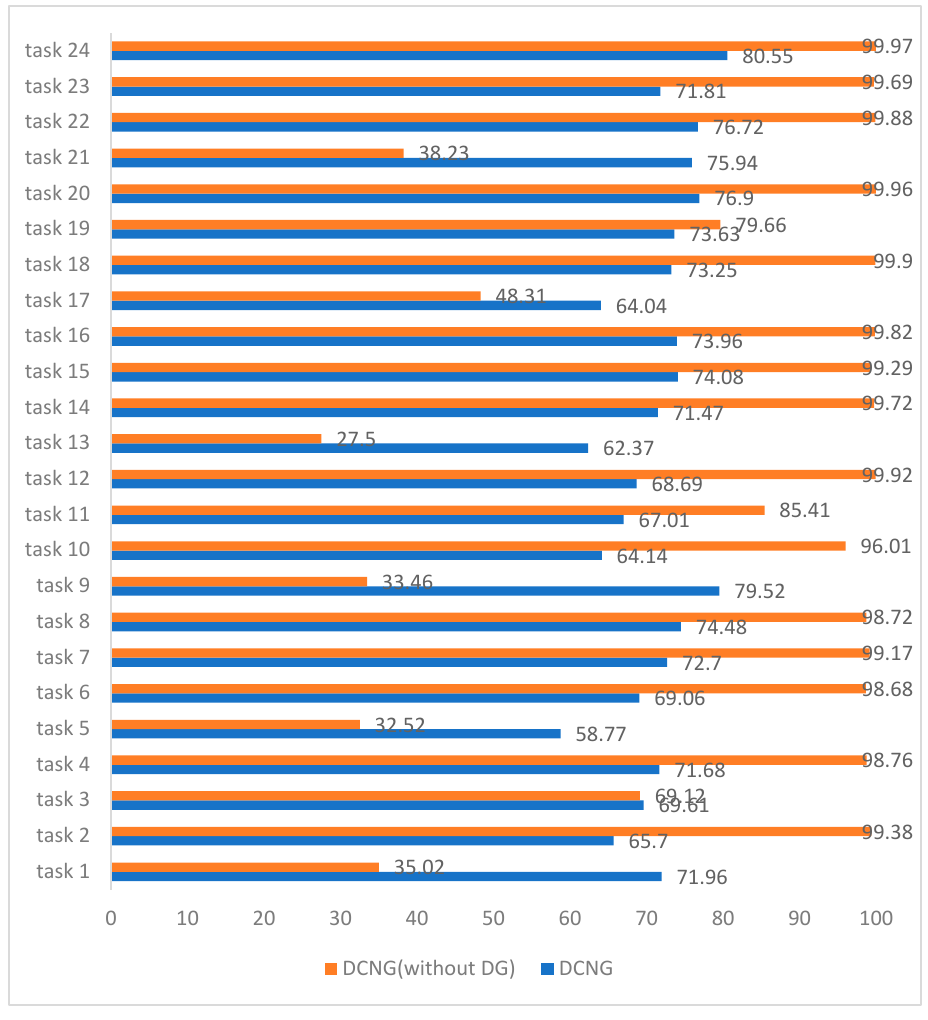
Figure 14. DCNG and ungeneralized model performance on 24 tasks in the KAT dataset.